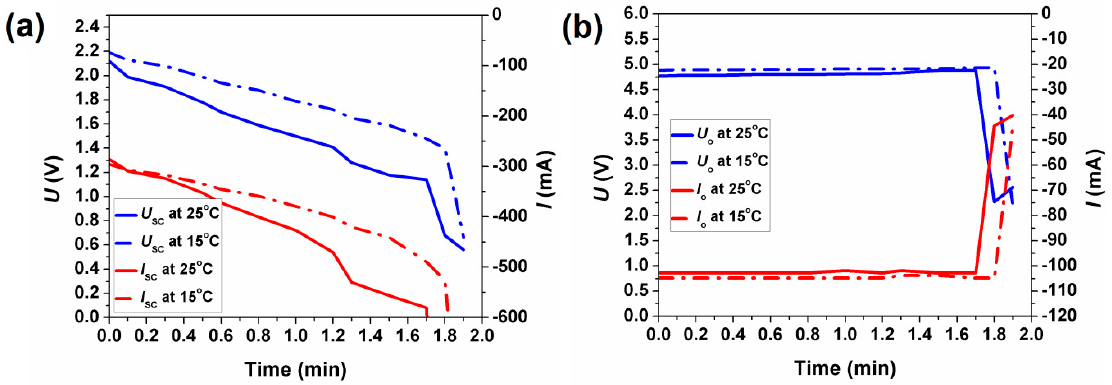
Figure 7. Supercapacitor discharge characteristics ( a ), and dependence of voltage and current on the resistor R o = 47 Ω during supercapacitor discharge ( b ).